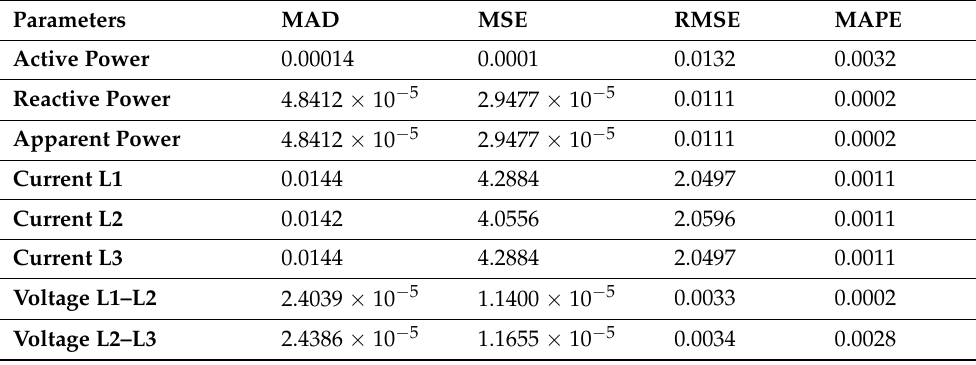
Table 7. Simulation results evaluation for generator.